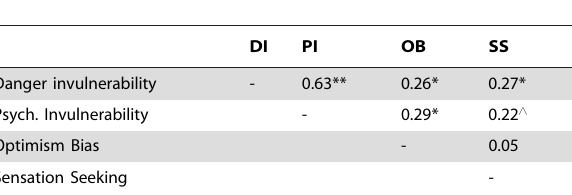
Table 2. Correlations between self-report surveys for subjective invulnerability, optimism bias, and sensation seeking.